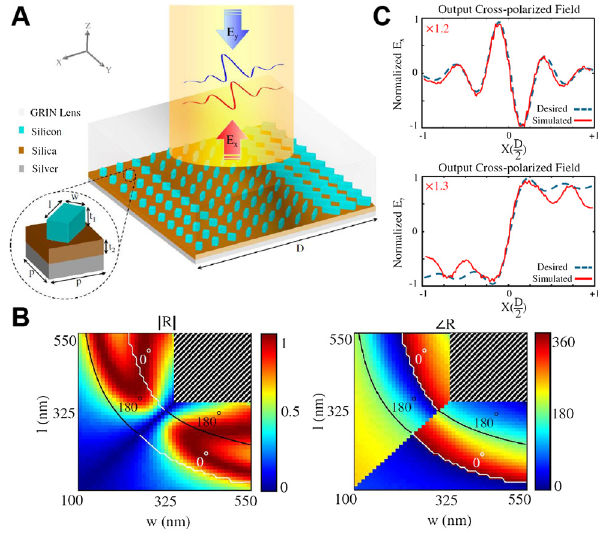
Figure 5: Analog optical computing using hybrid dielectric – plasmonic metasurfaces [38]. (A) Schematic representation of the dielectric graded-index (GRIN) media/hybrid metasurface to perform mathematical operations including spatial differentiation and integration. The metasurface is composed of an arrangement of silicon (Si) nanobricks on an oxide layer deposited on a silver (Ag) substrate. (B) Simulated amplitude and corresponding phase profiles of the reflected cross-polarized light considering the rotation angle of 45 ° with respect to the x -axis for the constituent nanoresonator. (C) Comparison of the simulated re fl ected cross-polarized fi eld and the exact analytical solution for the fi rst-order differentiator (top panel) and fi rst-order integrator (bottom